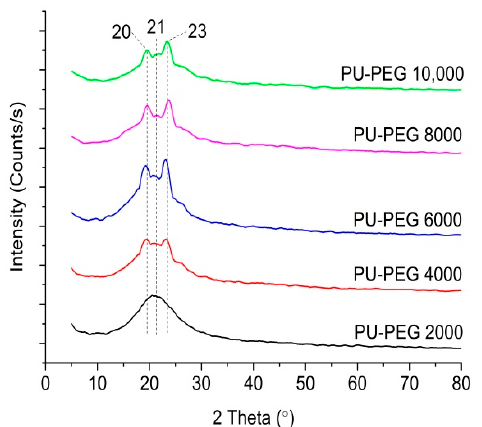
Figure 5. XRD spectra of PU matrices of different PEG molecular weights.